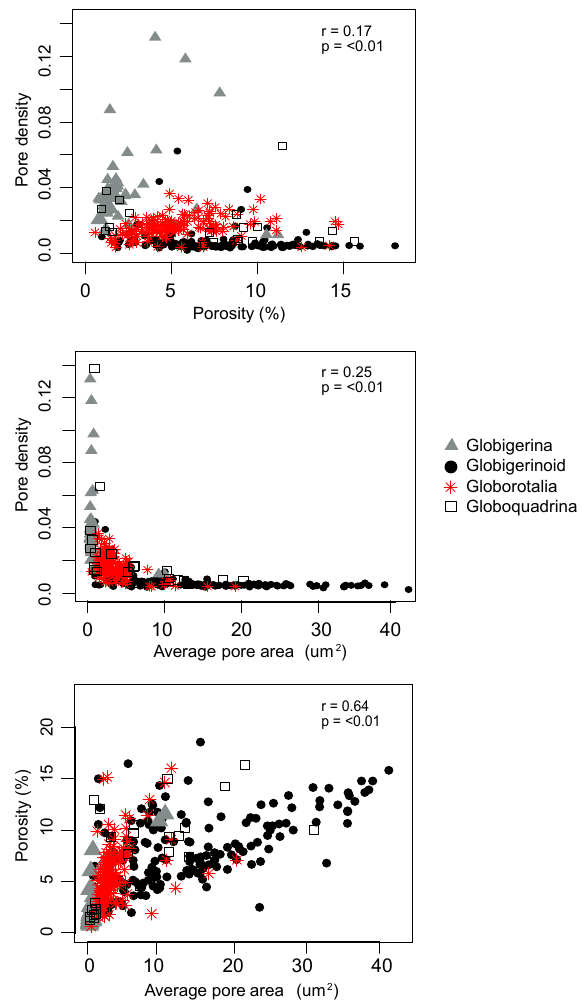
Figure 4. Scatter plots of pore variables (with results of pairwise linear regressions) to visualize the relationship between pore vari-